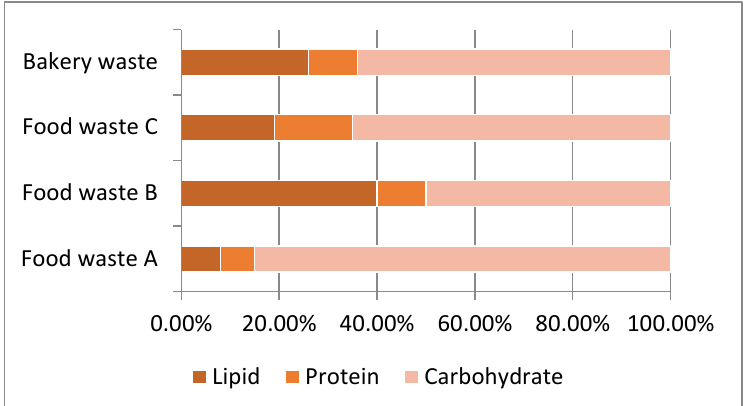
Figure 6. Percentage of lipids, proteins and carbohydrates in bakery and mixed food wastes. ( A , B ): Food waste obtained from the same canteen on separate days in Hong Kong; ( C ): Ready-to-eat food or restaurant waste; bakery waste obtained from a restaurant in Hong Kong.